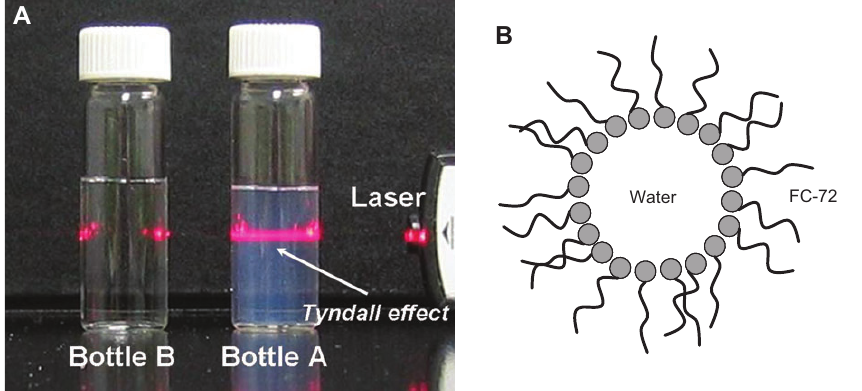
Figure 8 (A) The pictures of water in the FC-72 nanoemulsion fluids (Bottle A) and pure FC-72 (Bottle B). The liquids in both the bottles are transparent. The Tyndall effect can be observed only in Bottle A when a laser beam is passed through Bottles A and B. (B) The schematic diagram of a water nanodroplet dispersed in 3M ’ s FC-72 thermal fluid. A micelle of amphiphiles surrounds the nanodroplet, with the polar head interacting with the